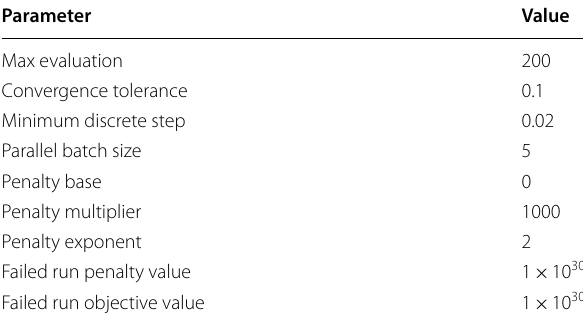
Table 7 Configuration parameters of evolution algorithm Parameter